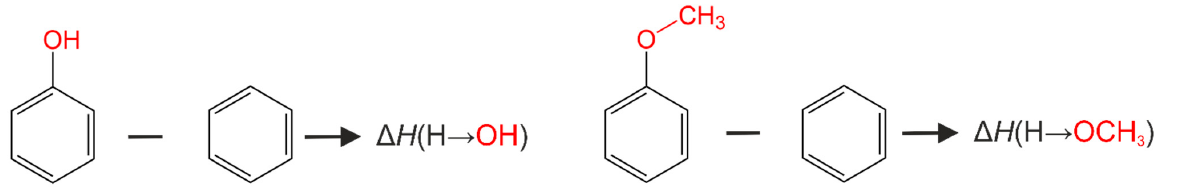
Figure 5. Quantification of the enthalpic contributions for the hydroxy ‐ and methoxy substituents. The scheme is valid for calculations with the standard molar enthalpies of vaporisation, as well as for the calculations with the gas ‐ phase standard molar enthalpies of formation.